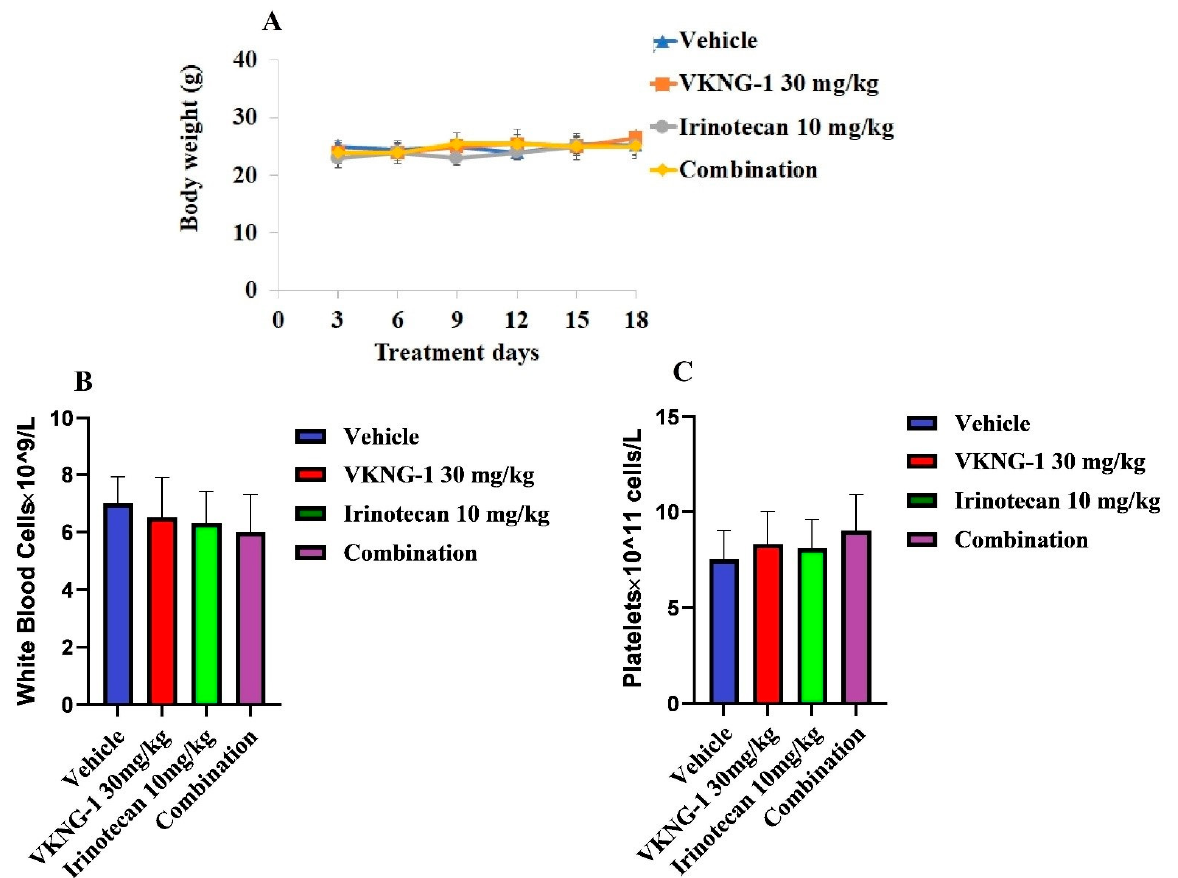
Figure 9. Changes in mean body weight before and after treatment for xenograft model are shown ( A ). The differences in mean white blood cells in nude mice ( n = 6) at the end of the 18-day treatment period ( B ) The changes in mean platelets in nude mice ( n = 6) at the end of the 18-day treatment period ( C ).